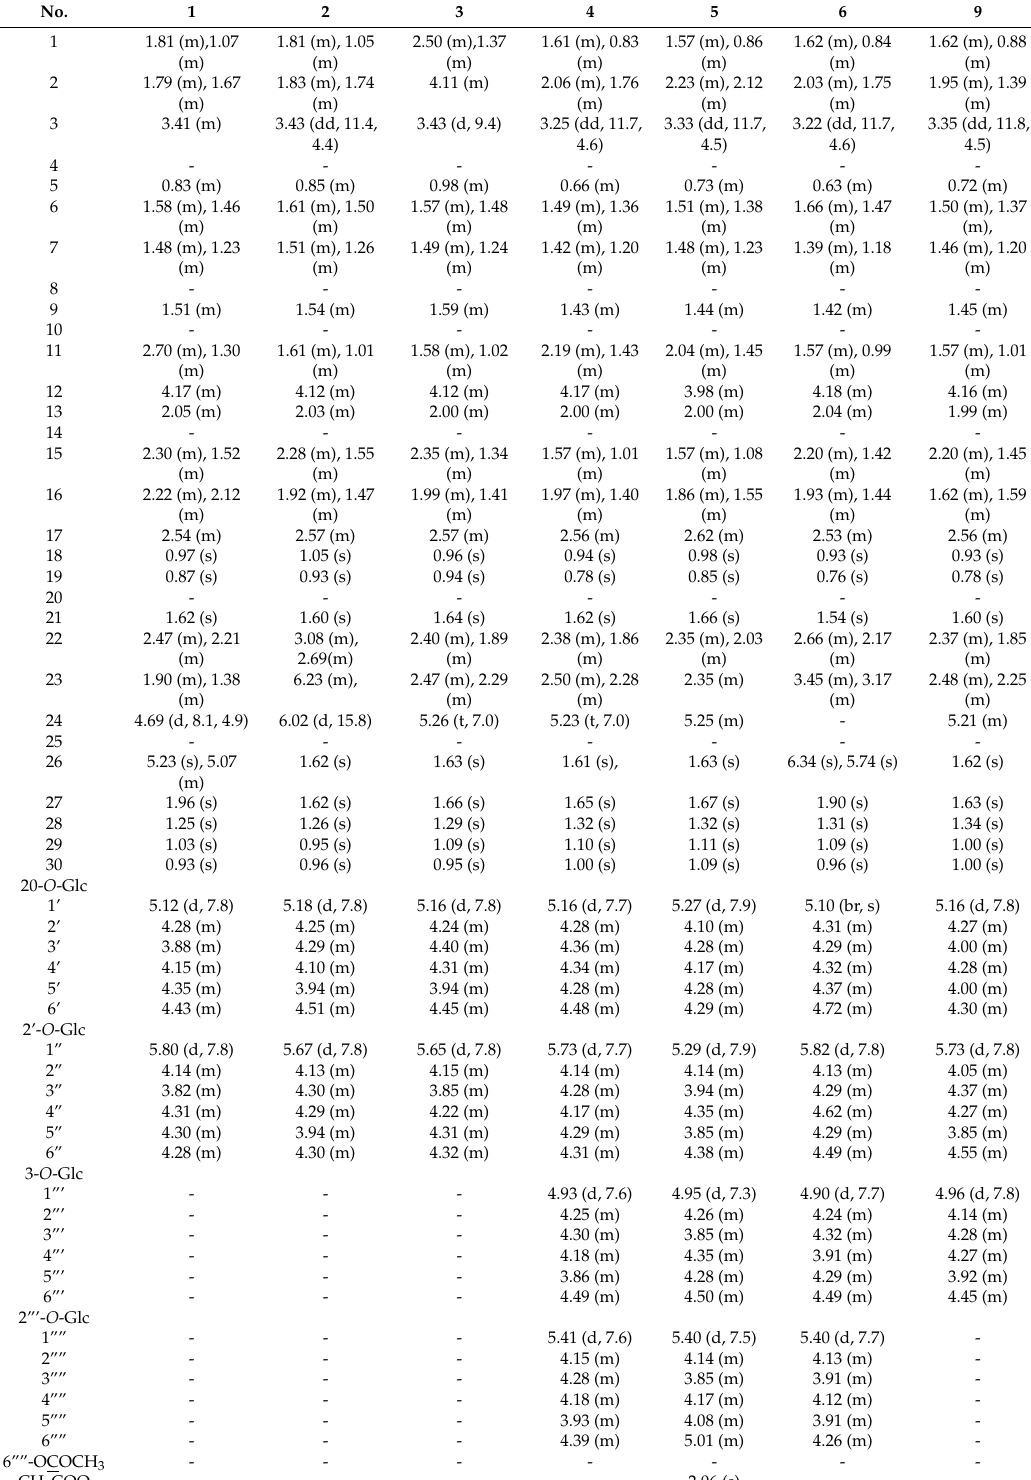
Table 1. 1 H-NMR data for compounds 1 – 6 , 9 (600 MHz, pyridine- d 5 , δ in ppm, J in